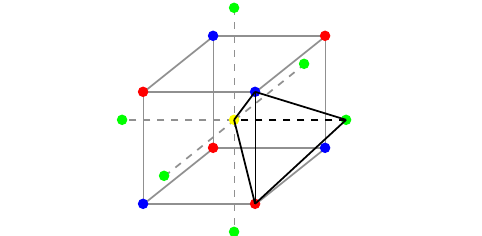
Figure 8: The BCC lattice is four-colorable. The pivot consists of an alternating sum of ZZZZ terms for all